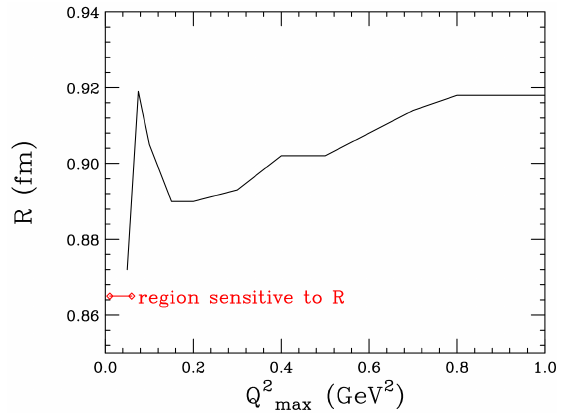
Figure 8. Proton rms-radius as a function of q max ≤ 5 fm − 1 of the data, from [64]. Indicated in red is the region of sensitivity to R as implied by Figure 4.